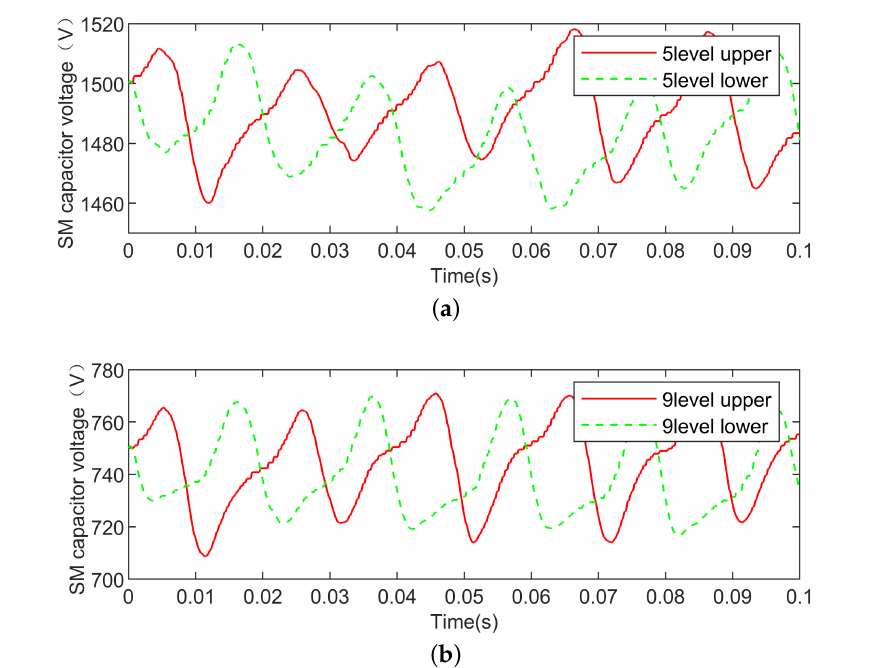
Figure 16. Capacitor voltage ( u SM , au , n , u SM , al , n ) waveforms of two cases: ( a ) one capacitor voltage in upper/lower arm in 5 level. ( b ) one capacitor voltage in upper/lower arm in 9